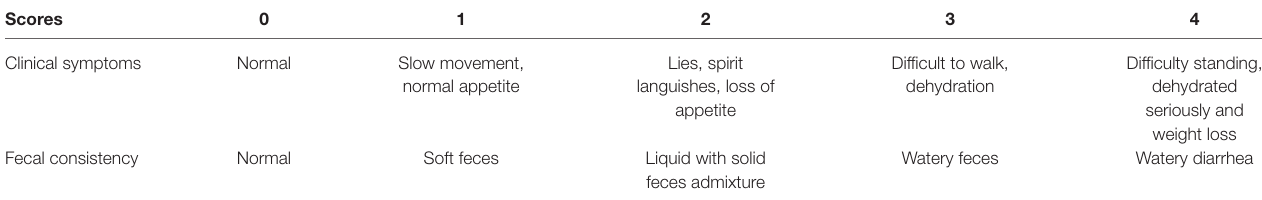
Difficult to walk, Difficulty standing, Lies, spirit dehydration dehydrated normal appetite languishes, loss of seriously and appetite weight loss Watery feces Watery feces admixture